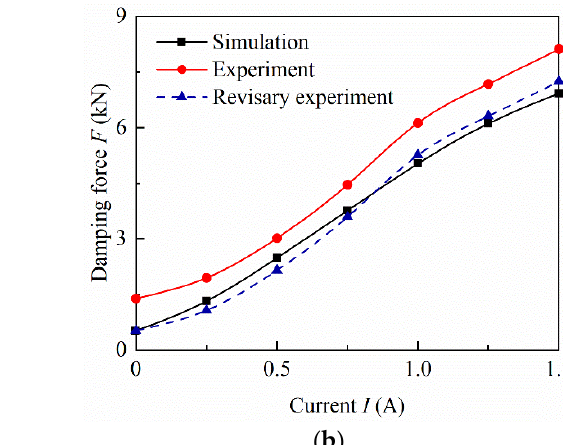
Figure 22. Comparison of dynamic between simulation and experiment.